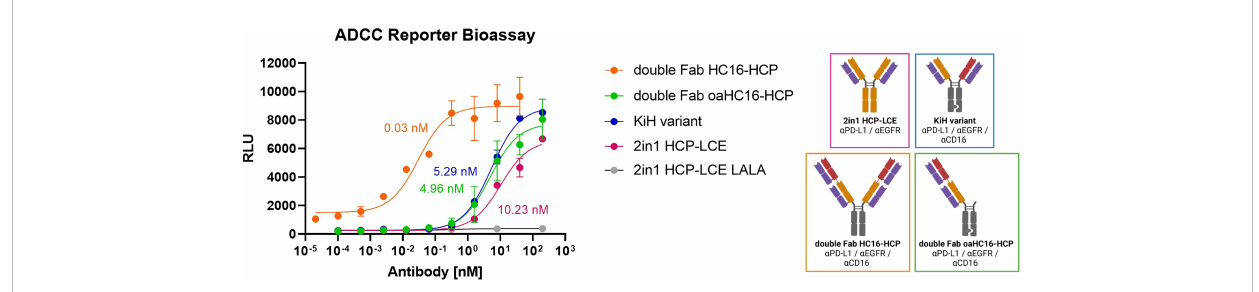
FIGURE 5 ADCC cell-based reporter assay. The trispeci fi c constructs KiH (blue), HC16-HCP (orange), oaHC16-HCP (green) and HCP-LCE (grey) with the LALA mutation were tested in comparison to HCP-LCE with a wildtype IgG1 Fc (pink). EC 50 values: HC16-HCP, 0.03 nM; oaHC16-HCP, 4.96 nM; KiH, 5.29 nM; HCP-LCE, 10.23 nM. Luciferase activity is plotted against the logarithmic antibody concentration. A variable slope three-parameter fi t was used to fi t the resulting curves. All measurements were performed in duplicates and the experiment was repeated at least three times, yielding similar results. Created with